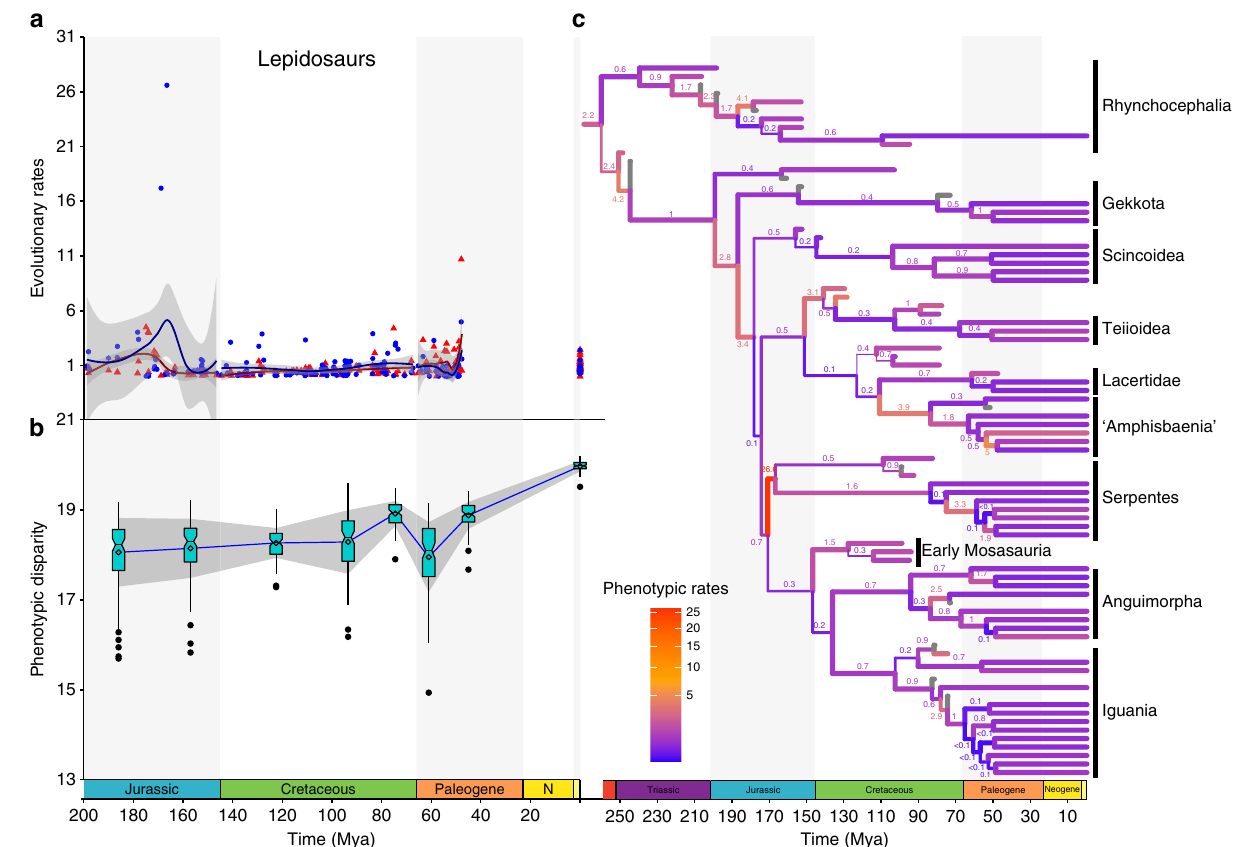
Fig. 3 Relative phenotypic and molecular evolutionary rates and disparity through time in lepidosaurs. Branch widths proportional to posterior probabilities for clades stemming from the respective branches. a phenotypic (blue) and molecular (red) rates among the major lepidosaur lineages from the Jurassic to the present time. Grey area represents 95% CI around LOESS regression line segmented by geological time bins. Triassic rates are not considered here due to low sample size and extremely large con fi dence intervals. b phenotypic disparity in early diapsids through time. Box plots represent distribution of 100 bootstraps at each time bin. Lower bound = 1st quartile (Q1); upper bound = 3rd quartile (Q3); notching = median; diamond = mean; minima = Q1-1.5xIQR; maxima = Q3 + 1.5xIQR; outliers = dots. Grey area represents 95% CI around LOESS regression line segmented by geological time bins (phenotypic = dark blue and molecular = dark red). n = 211 ( a , b ) for molecular and phenotypic evolutionary rates pooled from all unique bipartitions from the posterior trees. c phenotypic rates of evolution in reptiles plotted on the time-calibrated maximum compatible tree from Mr. Bayes. For full tree see Supplementary Figs. 5,